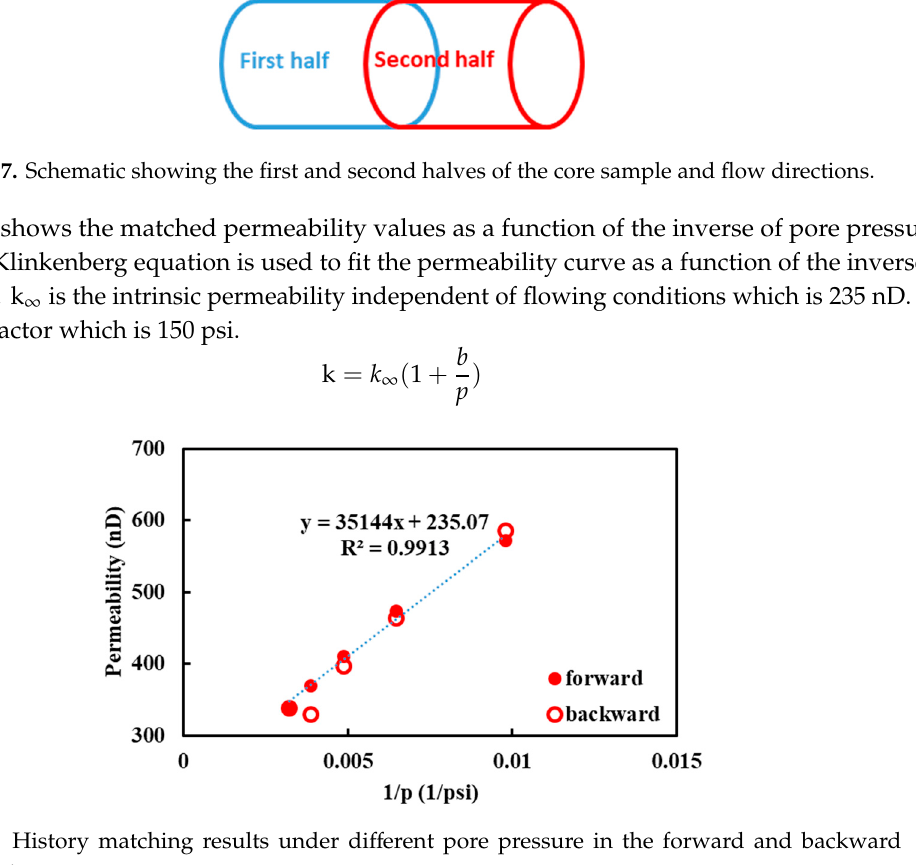
Figure 8. History matching results under di ff erent pore pressure in the forward and backward flow directions.